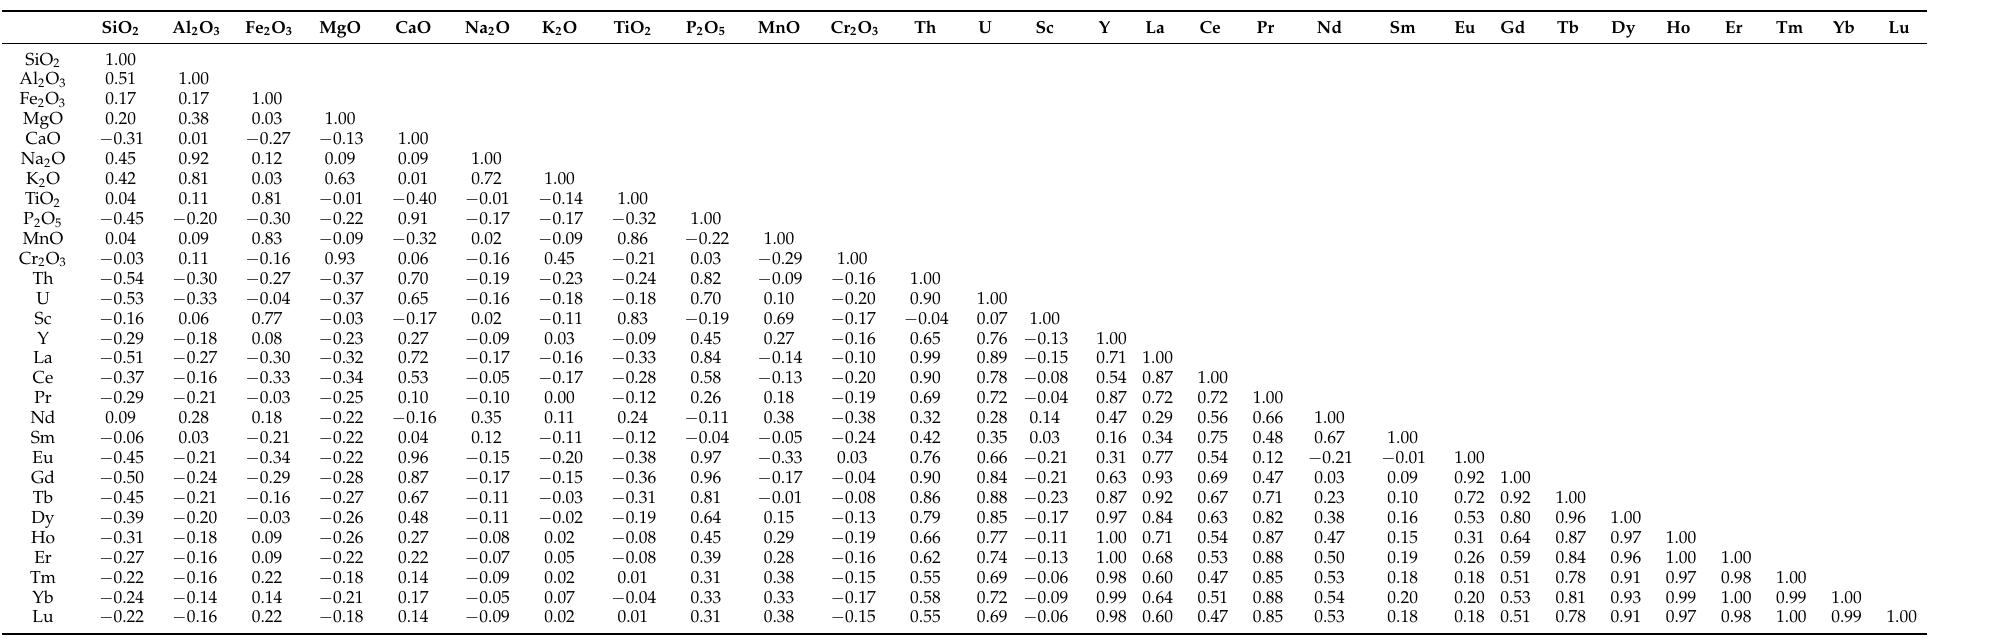
Table 7. Correlation matrix of oxides and elements in studied samples ( n =